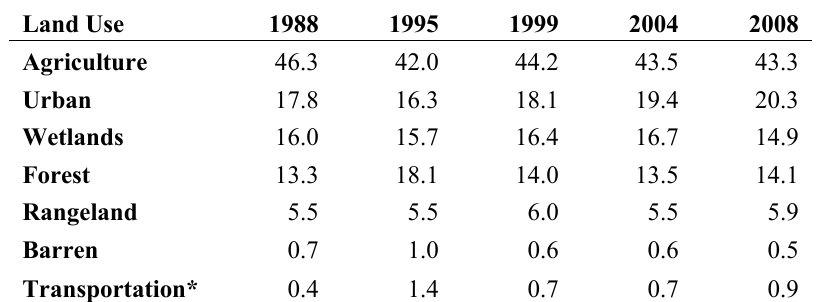
Table 2. Land-use distribution (% of analyzed area, 1988–2008) in the study